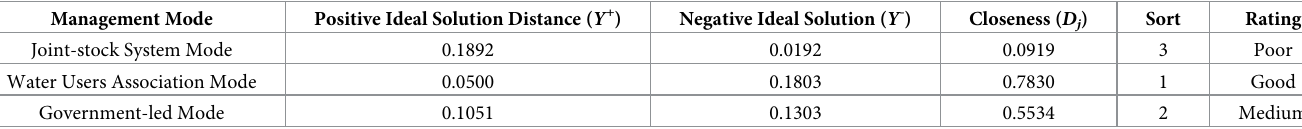
Table 9. Overall management performance evaluation under three management